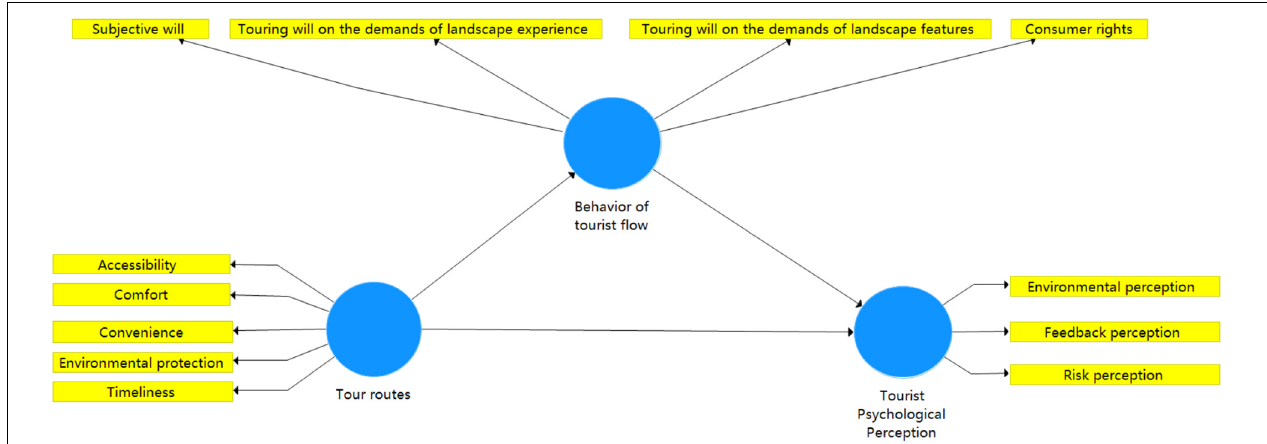
FIGURE 1 | The point and line linking model of tourism destinations in the space and time dimension.